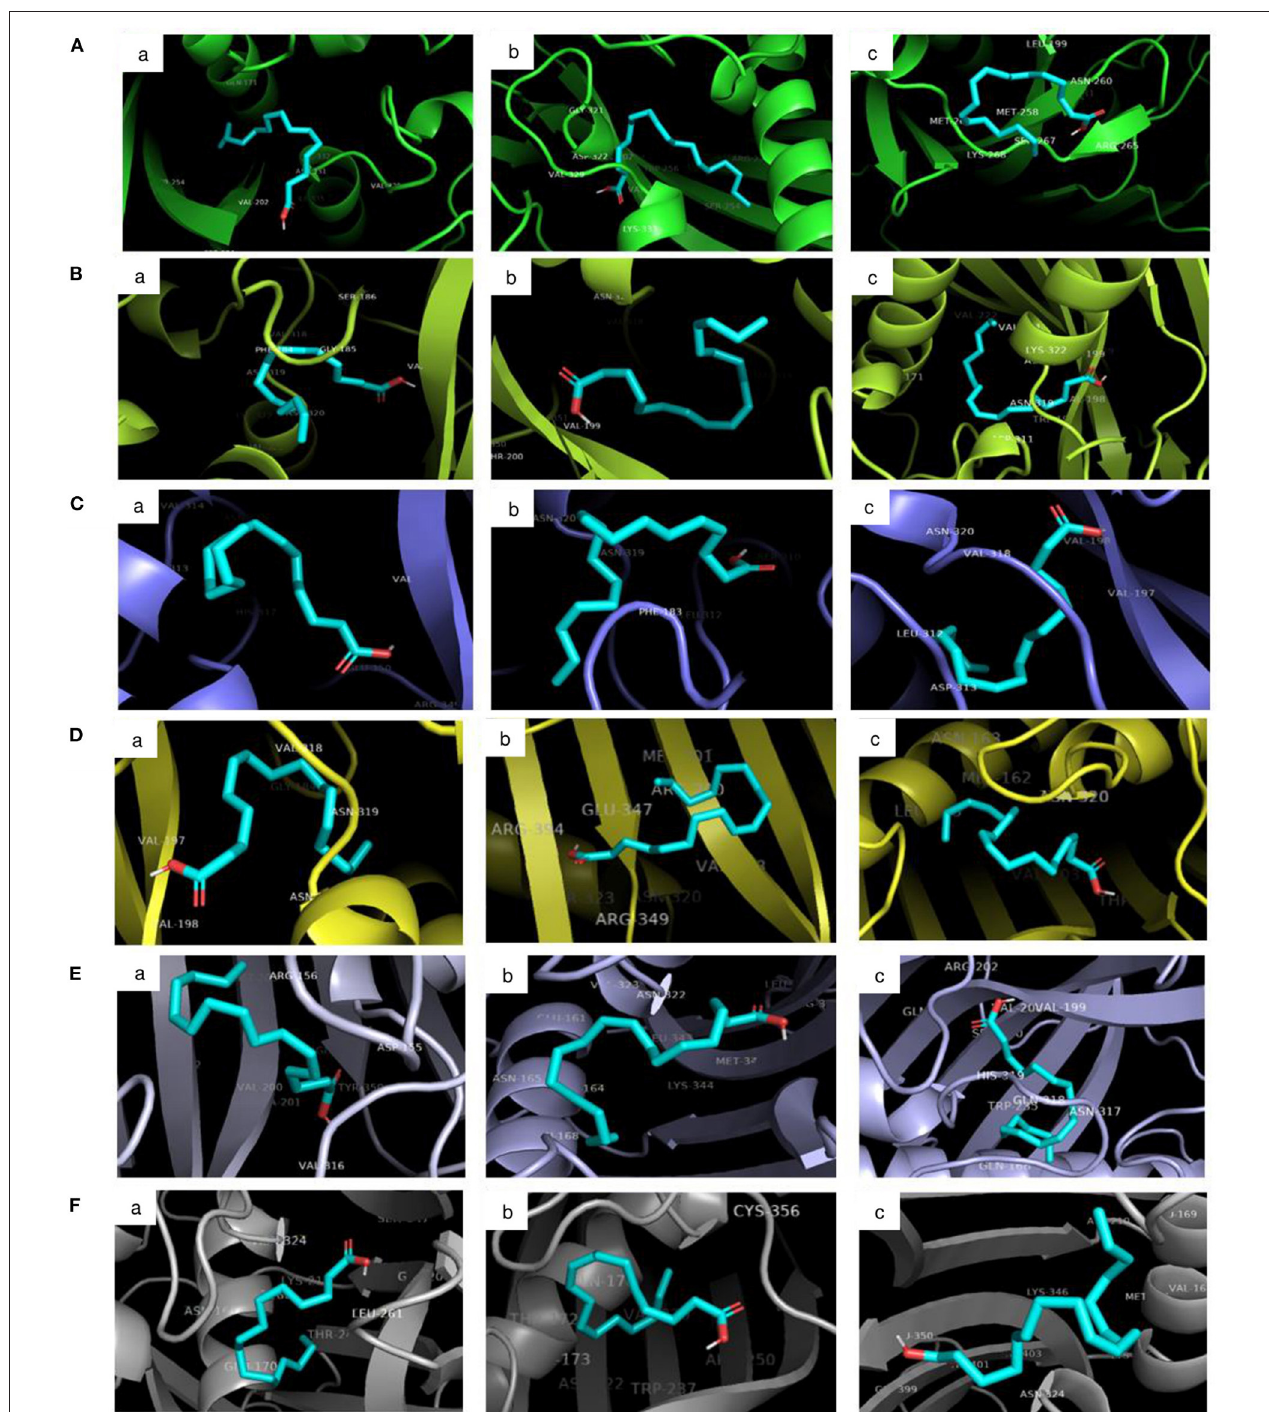
FIGURE 7 | 3D visualisation of the interaction between protein and ligands in PyMOL. The ligand-binding pose showing the highest binding affinity with the least root mean square deviation (RMSD) was selected. Proteins accessions of (A) Maize B73 protein (NP_001357940.1); (B) Soybean (KRH63043); (C) Sunflower (OTG24573); (D) Arabidopsis (AT1G08510.1); (E) Brassica (A0A078GBF8); (F) Camelina (Csa03g011960.1). Ligands namely (a) Palmitic acid; (b) Oleic acid; (c) Linoleic acid.